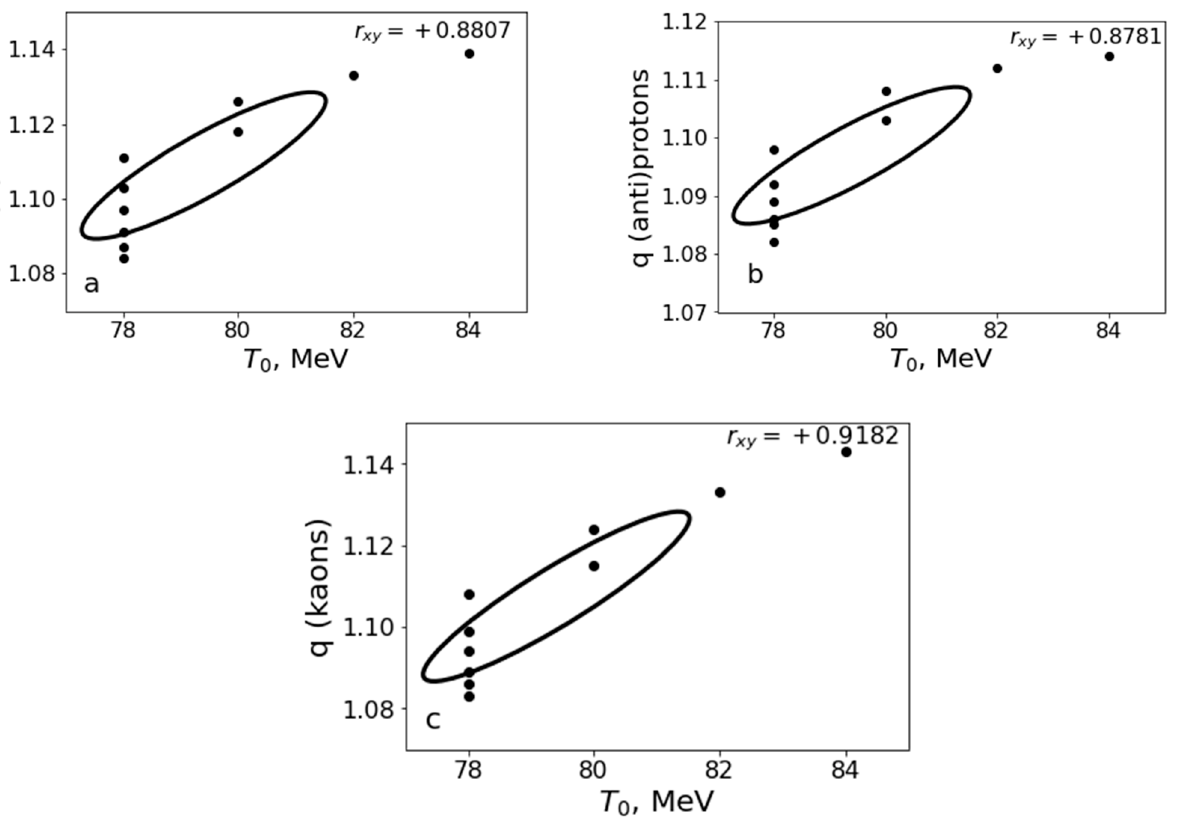
Figure 8. The q (pions) versus T 0 ( a ), q ((anti)protons) versus T 0 ( b ), and q (kaons) versus T 0 ( c ) dependencies, obtained using Equation (5) and presented in Table 2. The corresponding 1-sigma confidence ellipses and Pearson correlation coefficients are also shown in the figures.